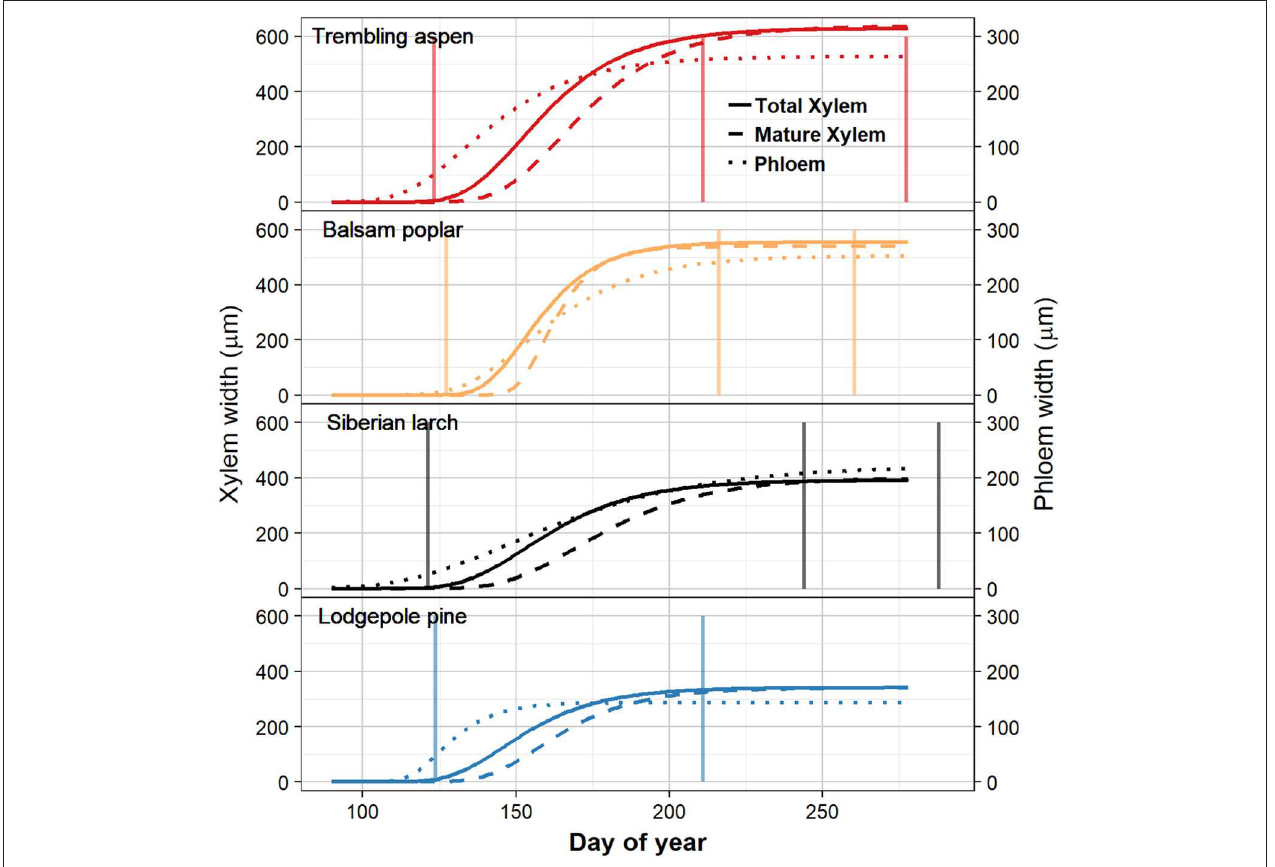
FIGURE 2 | Timing of xylem and phloem traits in four boreal tree species by day of year over a growing season inferred through Gompertz fits. The width of total xylem is indicated by the solid lines. Mature xylem that has completed the enlarging and wall-thickening states is indicated as dashed lines. The width of the 2018 phloem increment is indicated by dotted lines. Species are aspen, balsam poplar, Siberian larch, and lodgepole pine. The vertical lines, from left to right, show the time of budburst, bud set, and leaf senescence (not shown for lodgepole pine, which is